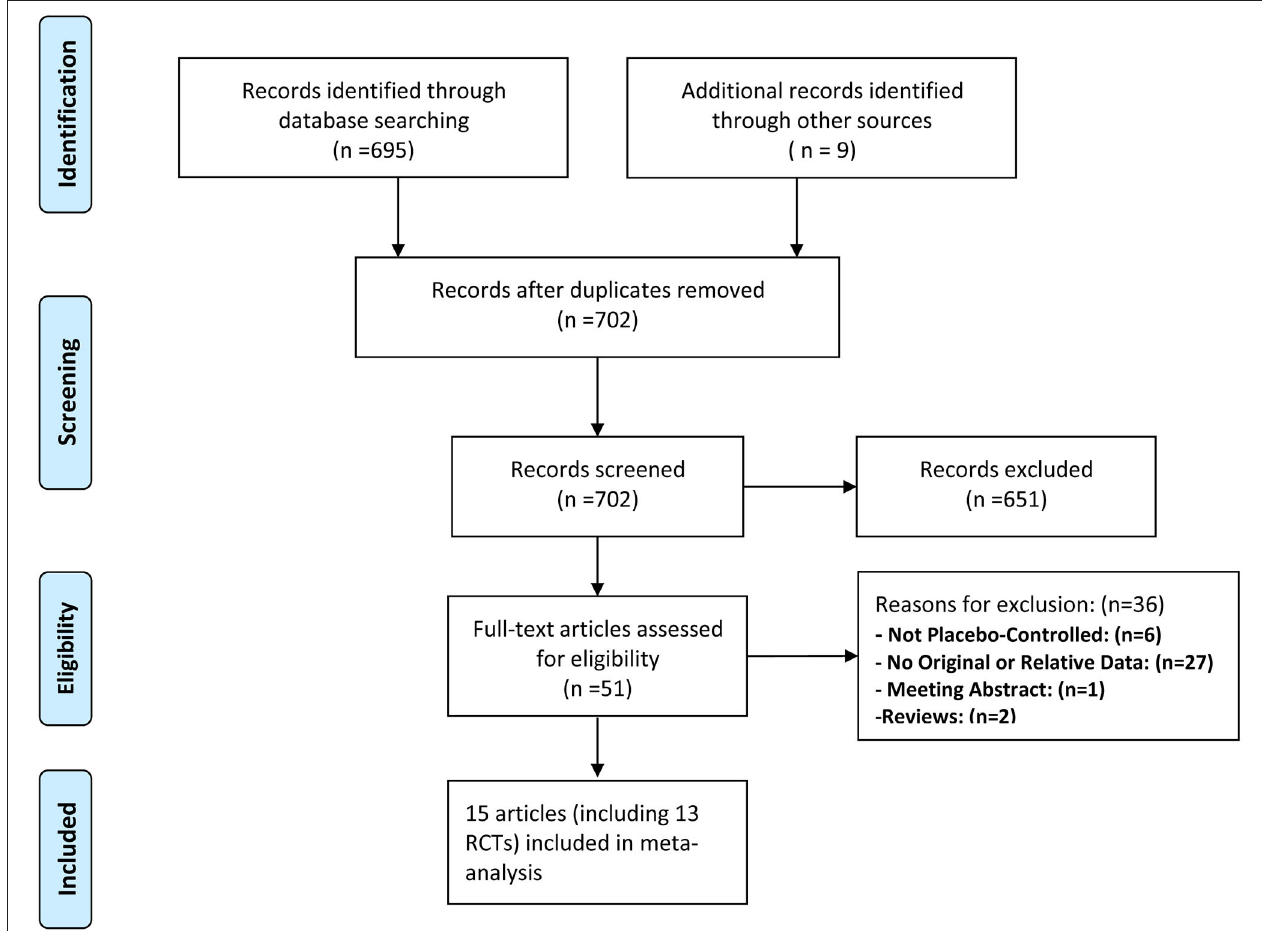
FIGURE 1 | Preferred Reporting Items for Systematic Reviews and Meta-analysis (PRISMA) flow diagram of study